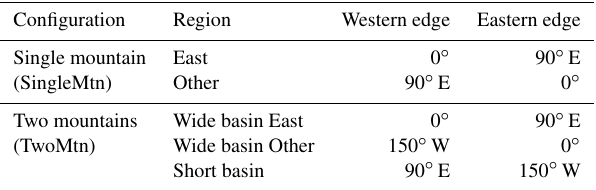
Table 1. Regions used for subsetting blocks in the compositing and duration analysis. Each region spans 30–65 ◦ N, for the longitudes listed in the